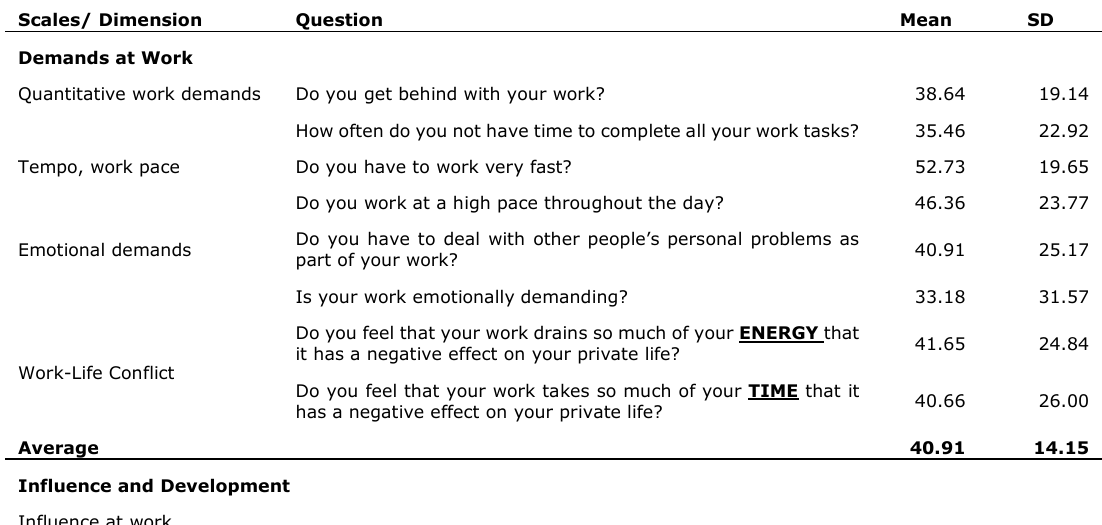
Table 3. Mean rating scores of CORE COPSOQ questions of off-shore personnel with average score per scale Scales/